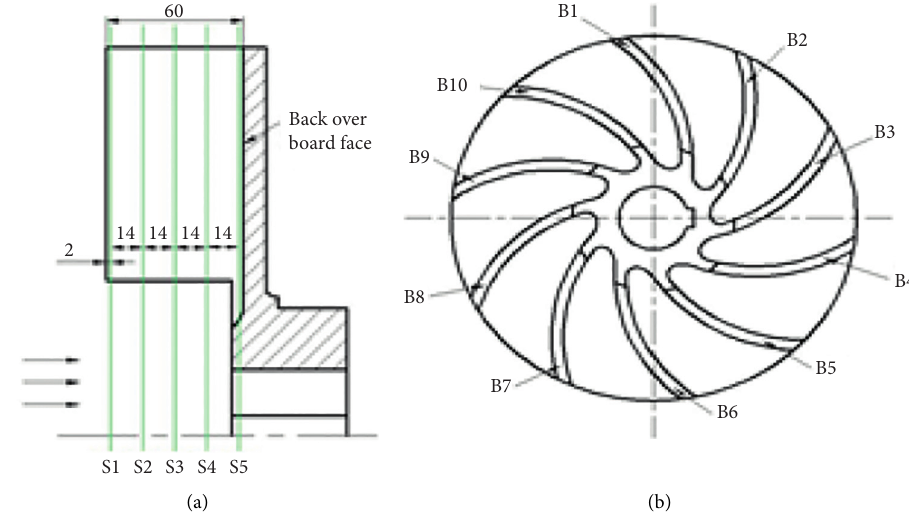
Figure 10: A sketch of the impeller: (a) cross-sectional position; (b) blade